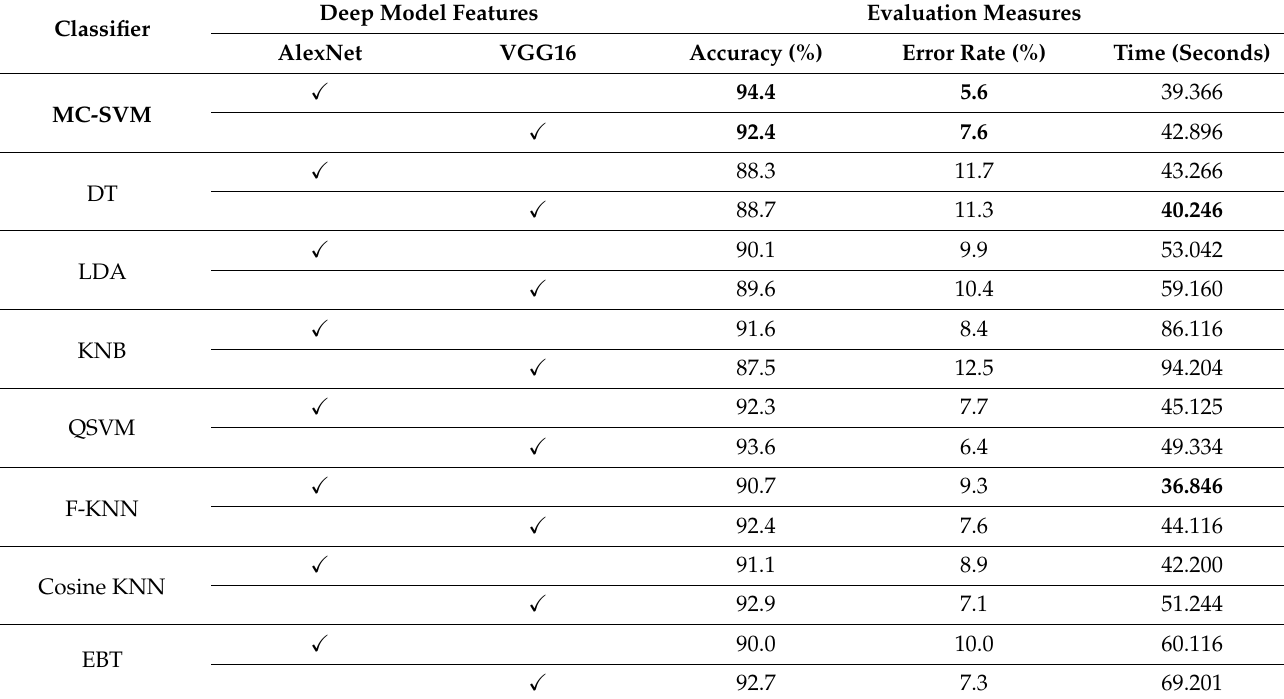
Table 2. Accuracy of deep models without using feature optimization and fusion